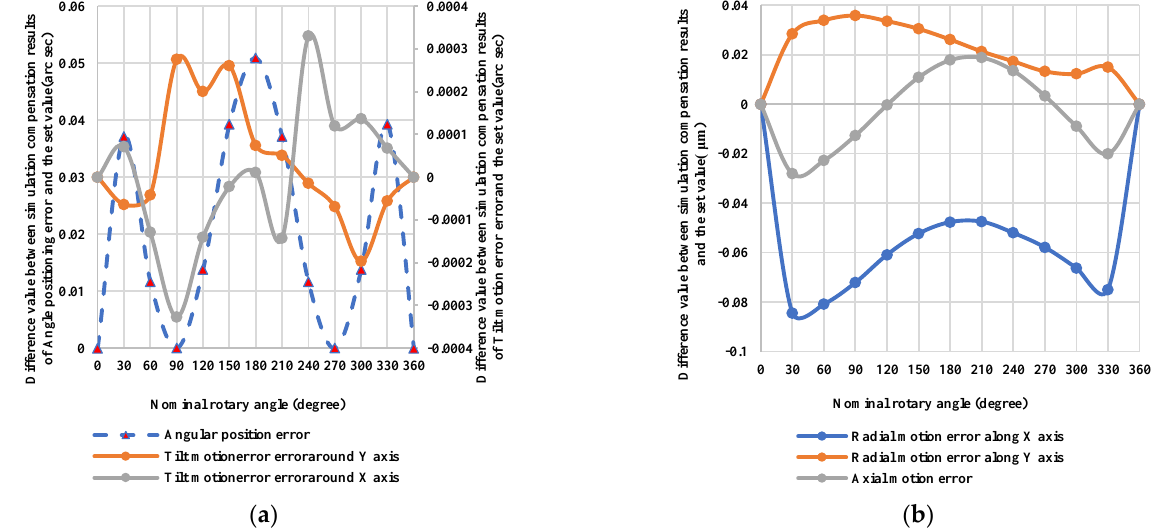
Figure 3. ( a ) The difference between the simulation compensation results of the angular positioning error and the tilt motion errors around the X and Y axes and the set value. ( b ) The difference between simulation compensation results of radial and axial motion errors and the set value.